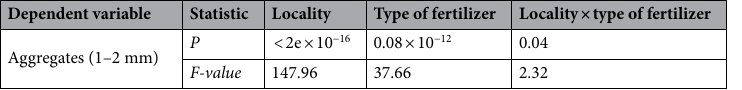
Table 1. Significances of the effects of locality, type of fertilizer, and interaction of the two on stability of 1–2 mm soil aggregates as revealed by two-way ANOVA.